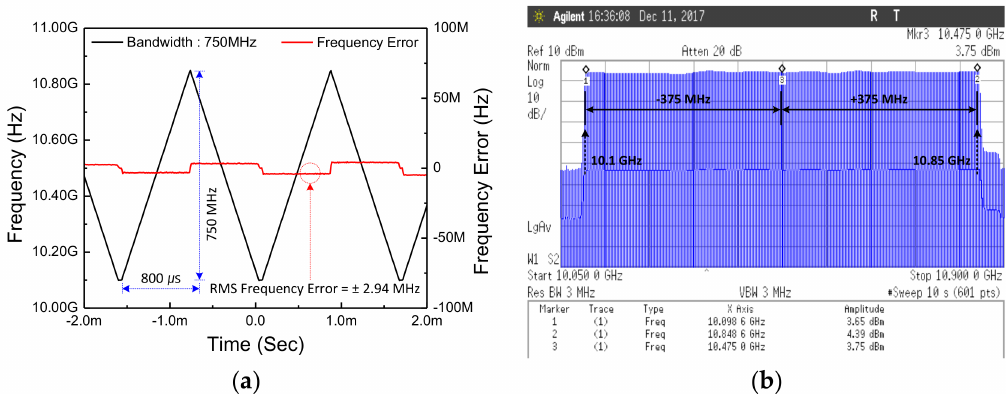
Figure 24. The waveform of frequency chirp with 750 MHz bandwidth is shown in ( a ) time domain and ( b ) frequency domain.